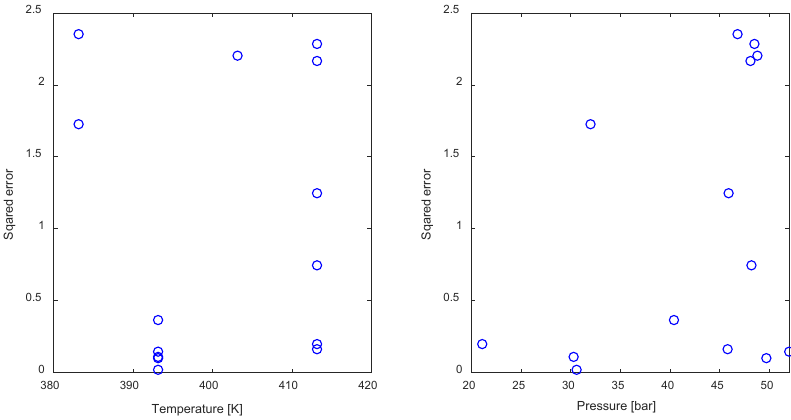
Figure 5. The squared errors plotted against the temperature and the pressure.